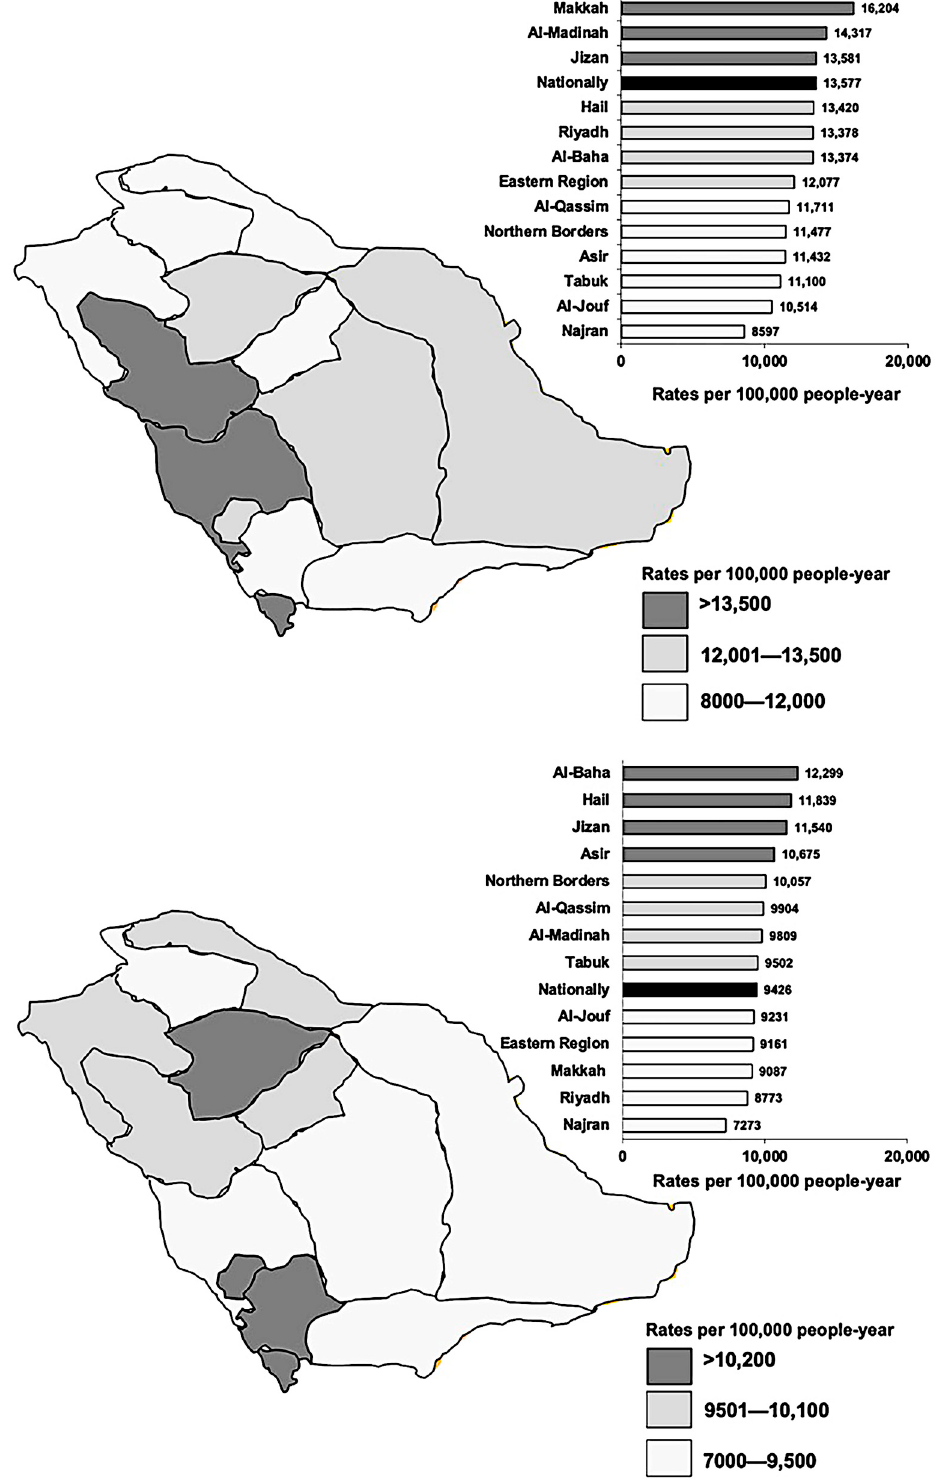
Figure 1. National and regional chronic disease rates by ( A ) total population and ( B ) Saudi population.